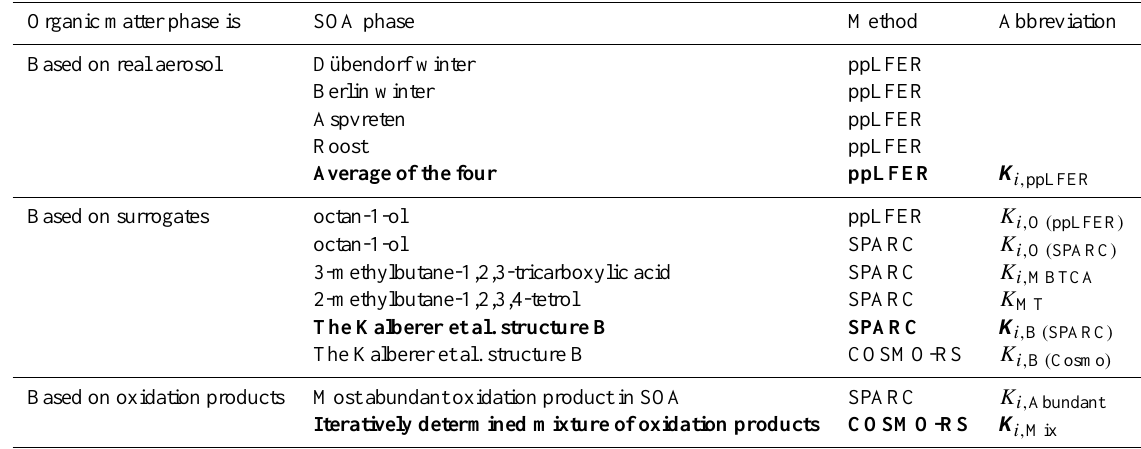
Table 1. Description and nomenclature for the 13 data sets for the equilibrium partition coefficient between the water-insoluble organic matter of aerosol and the gas phase K i, WIOM estimated with three methods. The three methods displayed in bold font are those selected for the inter-method comparison in Sect. 2.3.5.